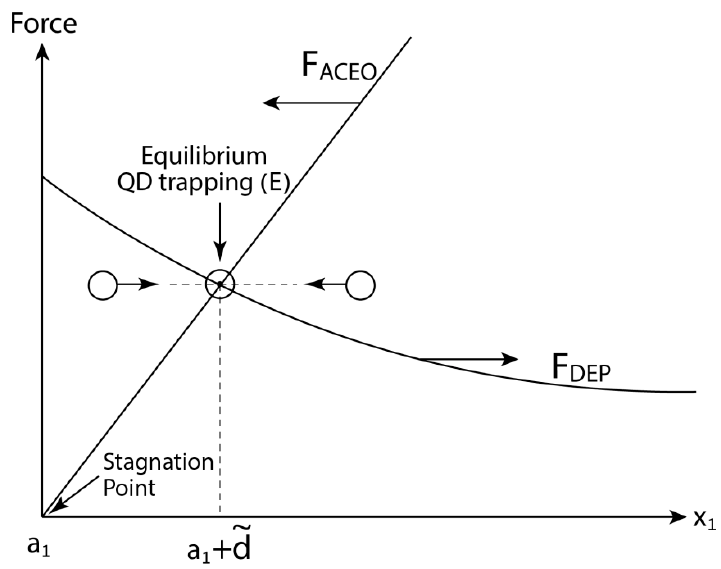
Figure 3. The competing effects between DEP and ACEO forces exerted on a free QD located on the longitudinal axis and demonstrating the existence of an equilibrium (saddle-like) trapping point (E) at a distance (cid:101) d from the nano-antenna.